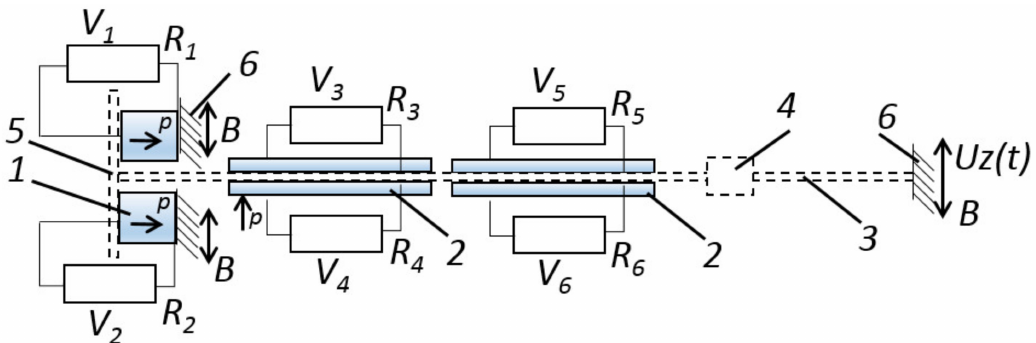
Figure 2. Electric scheme of axial-type PEG under active electric load and structure scheme of PEG with proof mass: 1—piezoelectric cylindrical element; 2—piezoelectric bimorph element; 3—substrate;